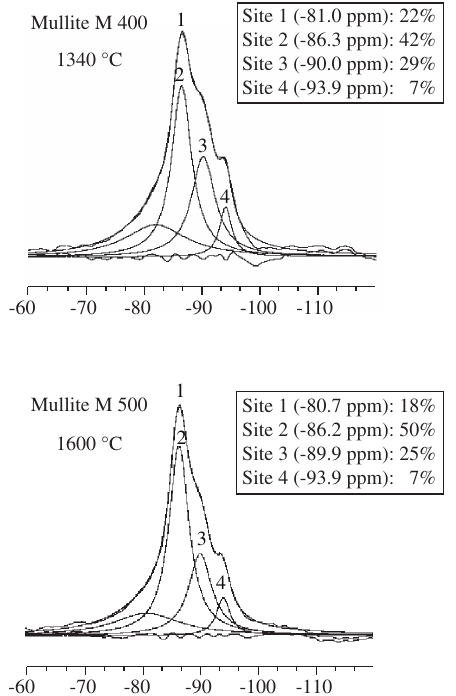
Figure 4. Experimental and deconvoluted 29 Si MAS NMR spectra of the M400 and M500 samples.